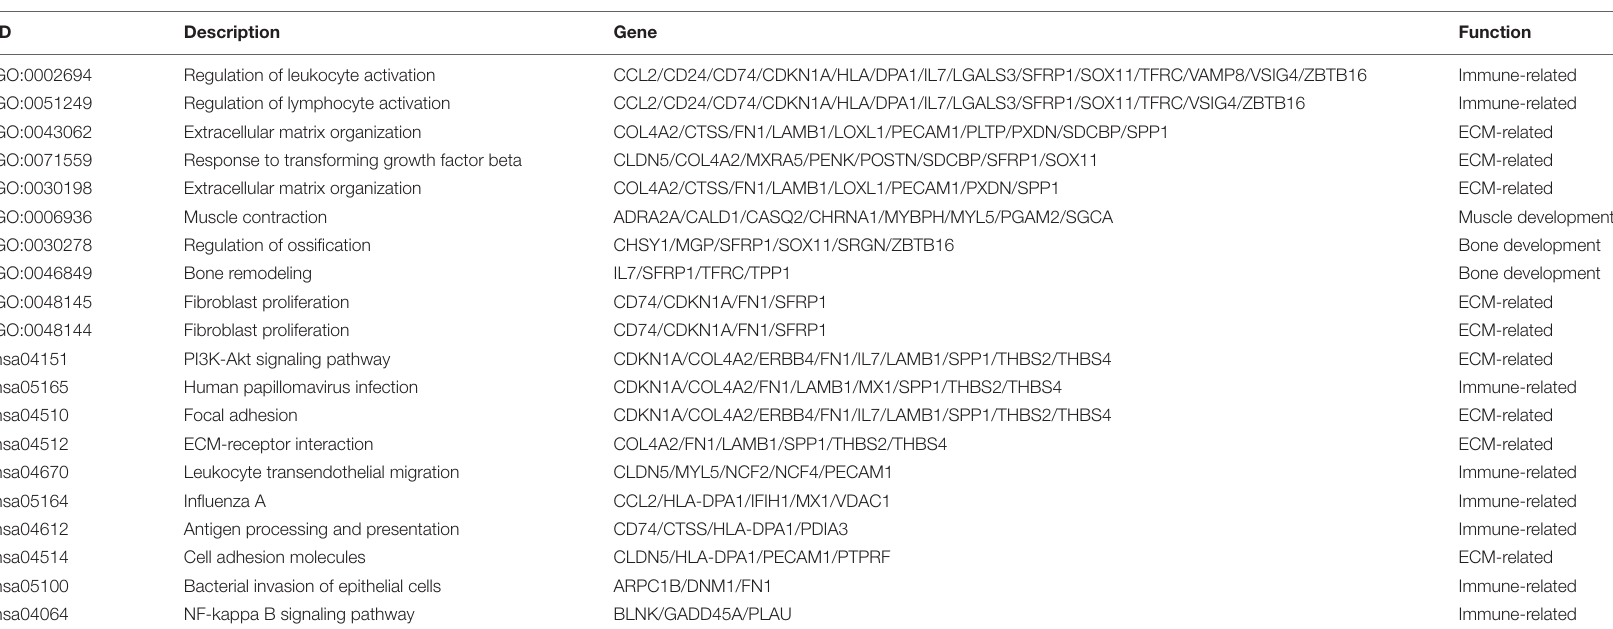
TABLE 3 | GO and KEGG